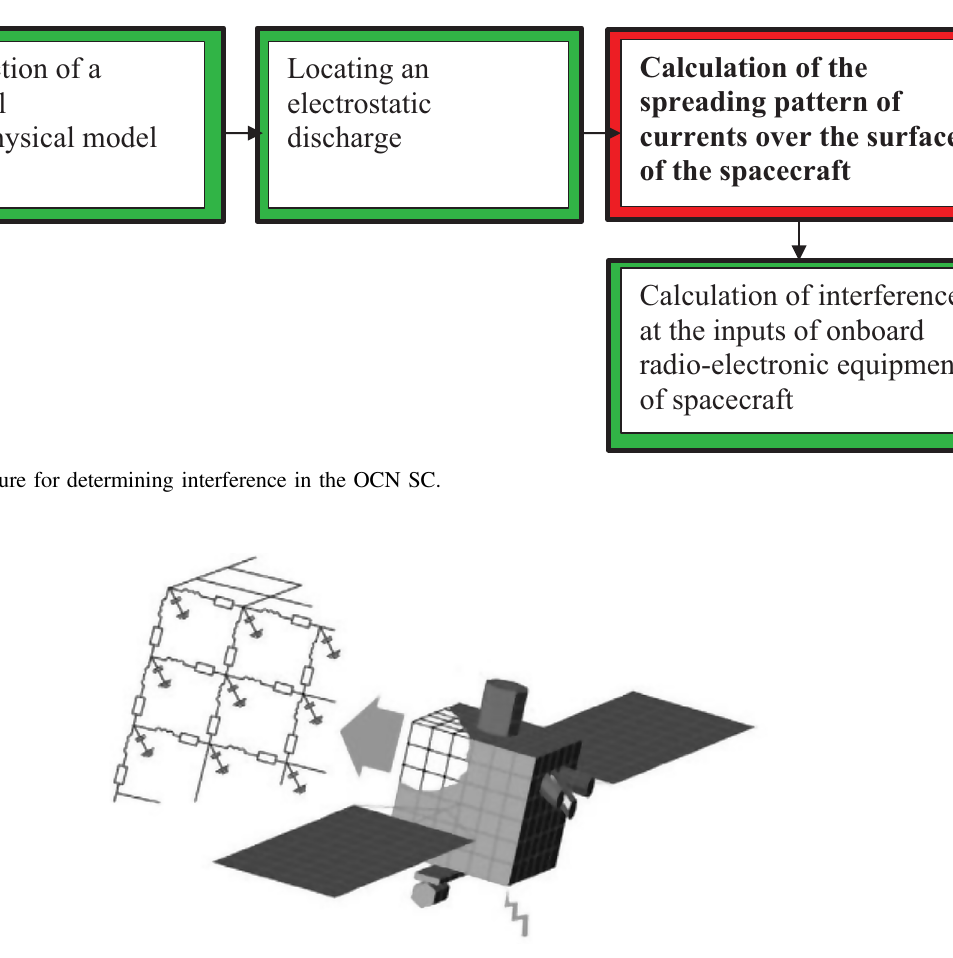
Figure 3. Converting a collection of quadrangles to an